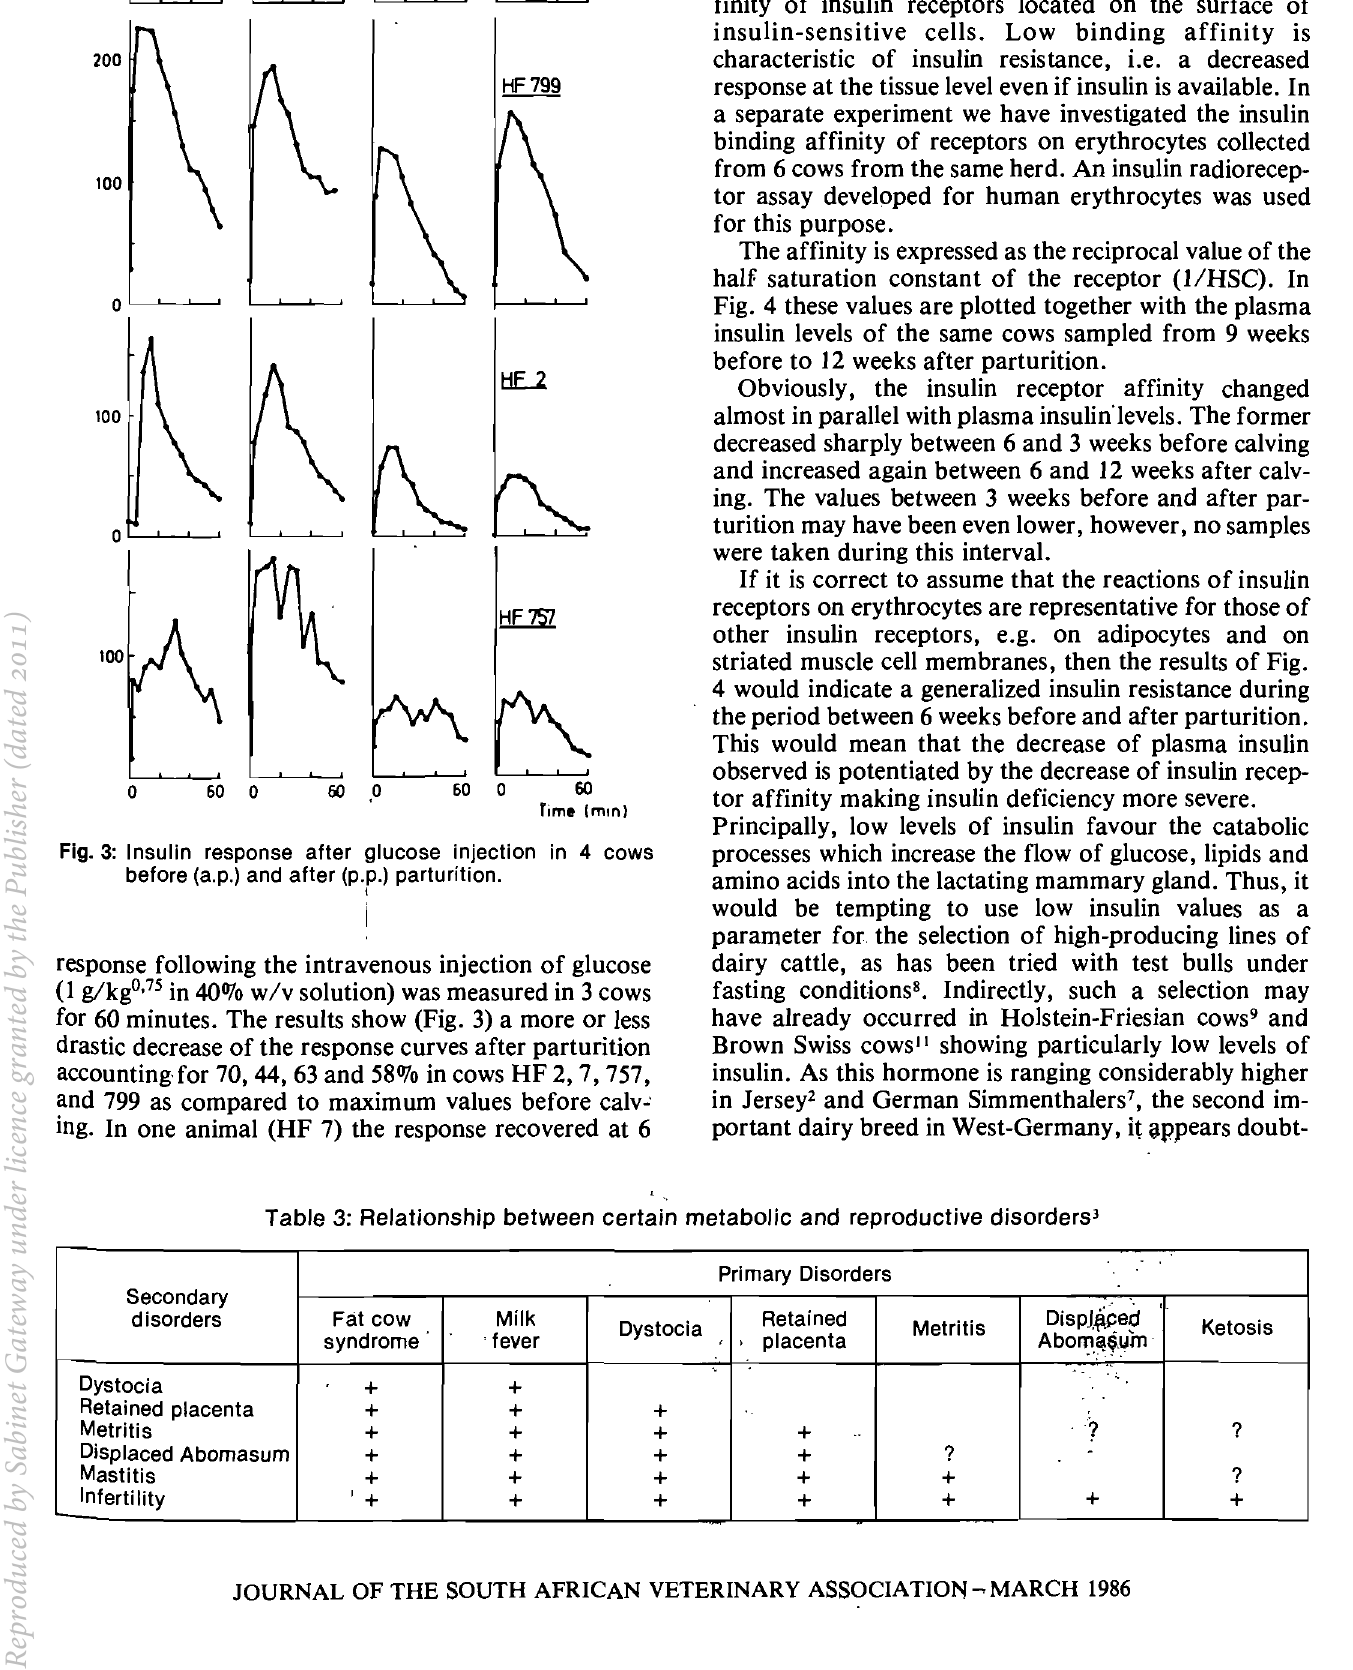
ing. In one animal (HF 7) the response recovered at 6